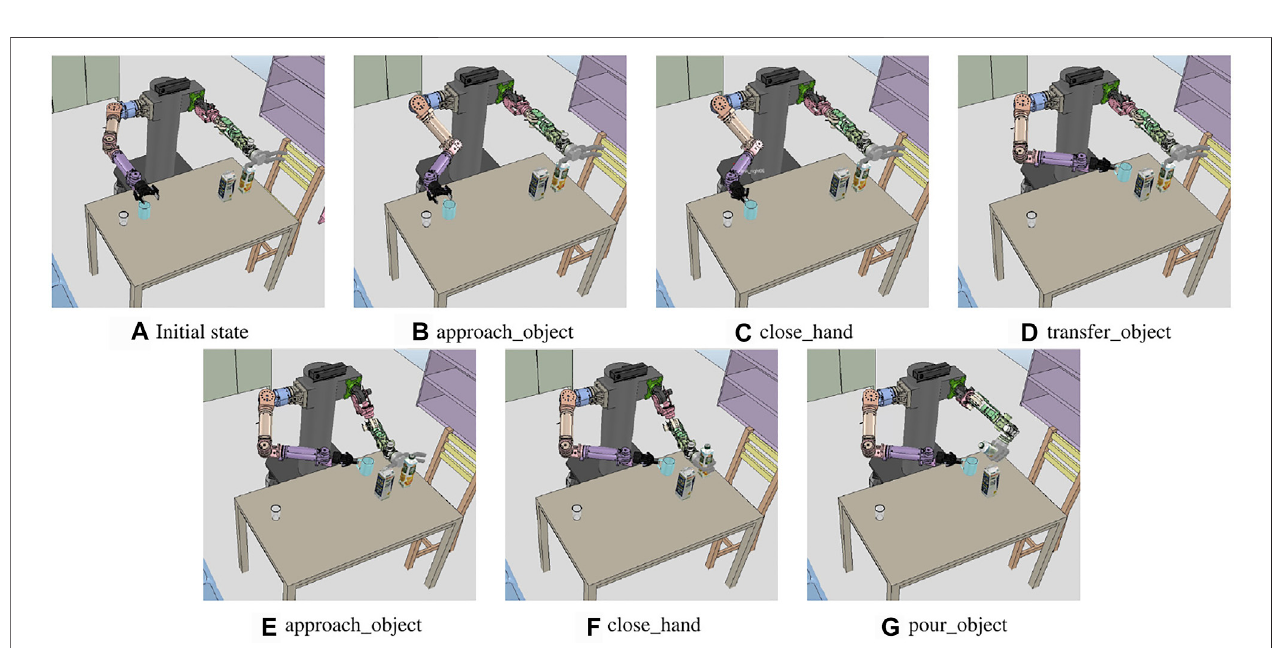
FIGURE 10 | Sequence of the execution snapshot for the juice pouring problem. (A) Initial state of the pouring problem. left _ hand , right _ hand , obj _ juice , obj _ milk , obj _ cup , and obj _ mug are recognized. (B – G) show the results of performing each primitive action.